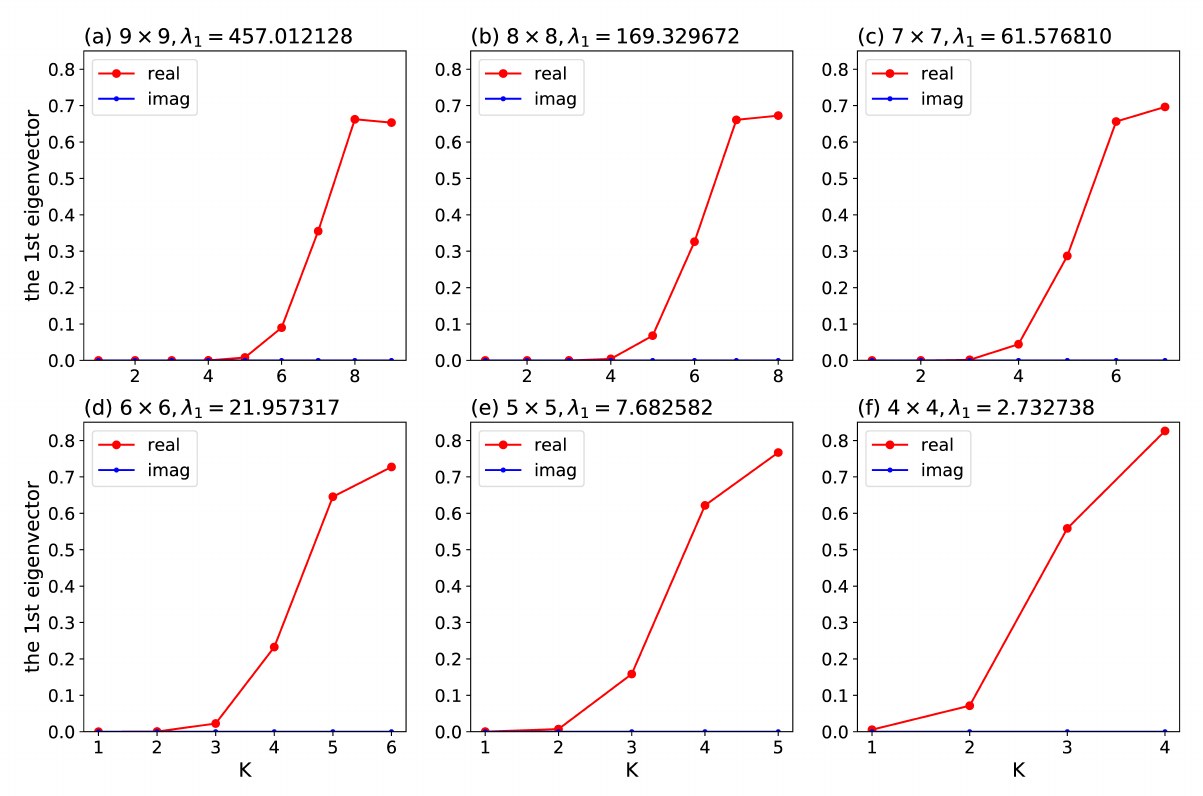
Figure 5. The first eigenvector of the 9 9 matrix from Table 4 of Rotunno and Synder, 2008 [32], and Figure 5: The first eigenvector of the 9 9 matrix from Table 4 of Rotunno and Synder (2008), and the 8 × × the 8 8, 7 7, 6 6, 5 5, and 4 4 sub-matrices, 7 7, 6 6, 5 5, and 4 4 sub-matrices, respectively. × × × × × × × × ×